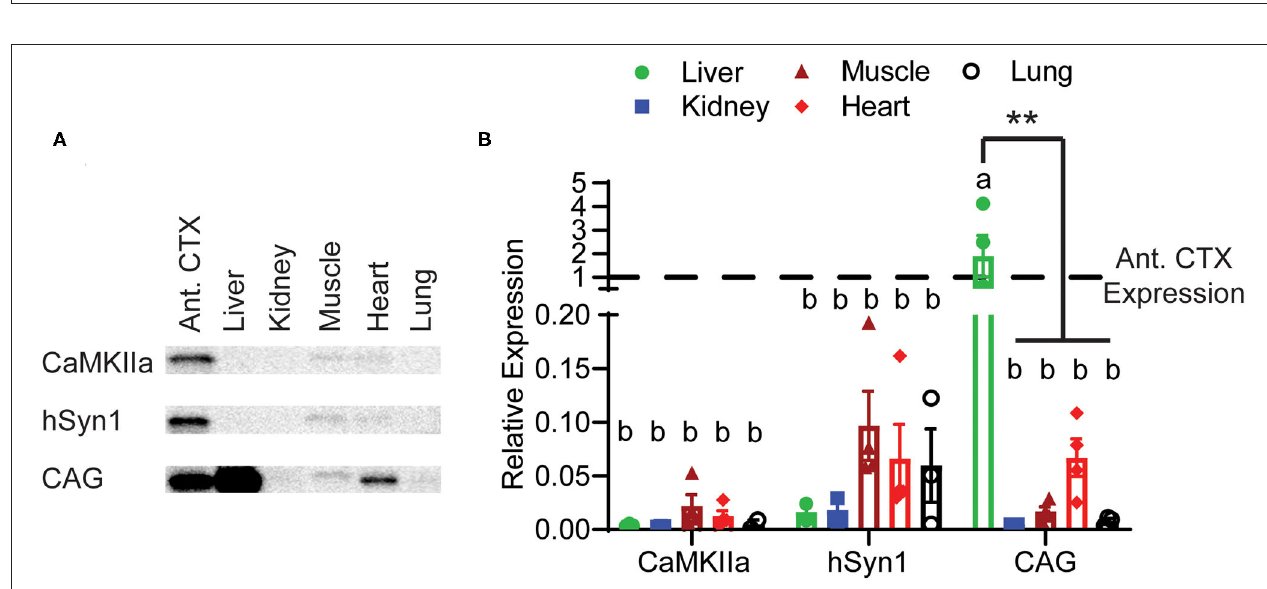
FIGURE 4 | Graph of mean fluorescent intensity of GFP signal from GFP + NeuN + cells. The CAG promoter drove greater per-neuron expression of GFP in the cortex than the hSyn1 promoter. Data points represent values for each mouse; mean ± SEM ( n = 4) are indicated. ** denotes p < 0.01; * denotes p < 0.05 by one-way ANOVA and Tukey’s post-hoc test. Bars annotated with the same lower-case letter are not statistically significant from each other. (C) Representative micrographs of the hippocampus and cortex. Apparent rotations in CA2 orientation resulted from section placement on slides. Similar areas indicated with rectangles on Figure 3C are enlarged here. Scale bar represents 25 µ m for all panels. CaMKII α , calmodulin dependent protein kinase II α ; hSyn1, human synapsin 1; Ant. CTX, anterior cortex; Post. CTX, posterior cortex; CER, cerebellum; HPC, hippocampus; CA2, subfield of hippocampus.